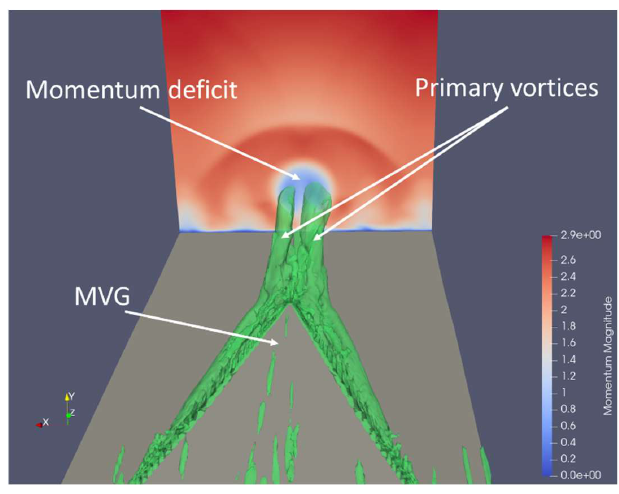
Figure 3. Two streamwise vortices in time-averaged